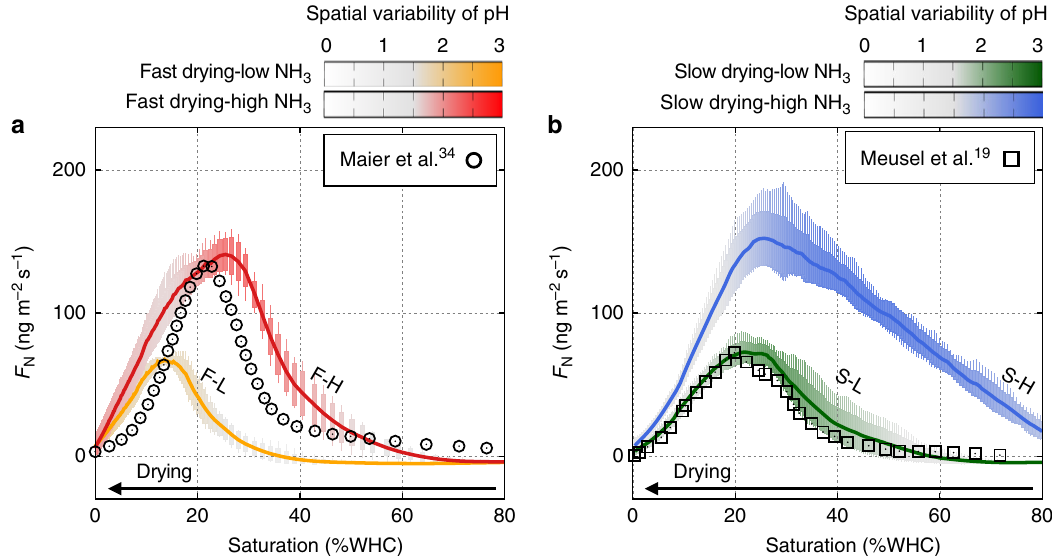
Fig. 7 Model prediction and observation of nitrous acid emission. Nitrous acid (HONO) gaseous emissions during biocrust drying as a function of soil hydration conditions (expressed in percent of water-holding capacity). Typical simulations of different conditions in drying patterns, and atmospheric ammonia (NH 3 ) levels (low: 5 ppb, high: 20 ppb) are denoted as slow/high drying with low-/high-NH 3 level, S – L (green), S – H (blue), F – L (orange), and F – H (red), respectively. The length of each box indicates ±1 standard deviation and each stick ranges the minimum and maximum emission of HONO from all simulations ( n = 8). Colour gradients indicate the averaged spatial variability of local pH values (given as ±1 standard deviation) across simulations. a Simulated HONO emission with fast drying under high NH 3 input was comparable with measurements from cyanobacteria-dominated crust in South Africa 34 . b Simulated HONO emission with slow drying under low NH 3 input was comparable with measurements from light crust in Cyprus